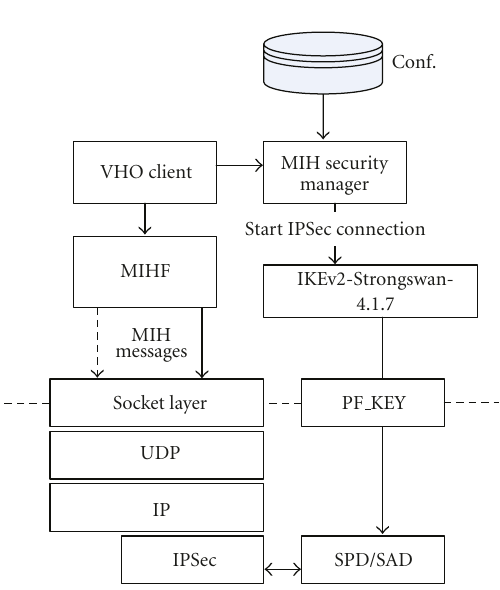
Figure 14: MIH extension header.